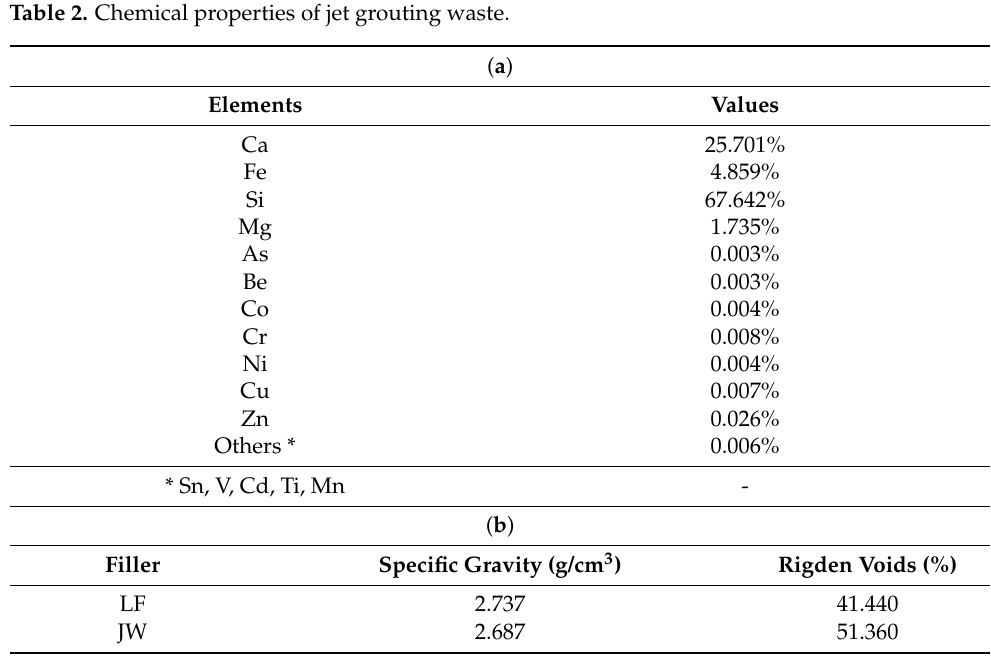
Figure 2. Limestone filler vs. jet grouting waste as filler. observed that it mainly composes of calcium (25.7%) and silicon (67.64%). Table 2. Chemical properties of jet grouting